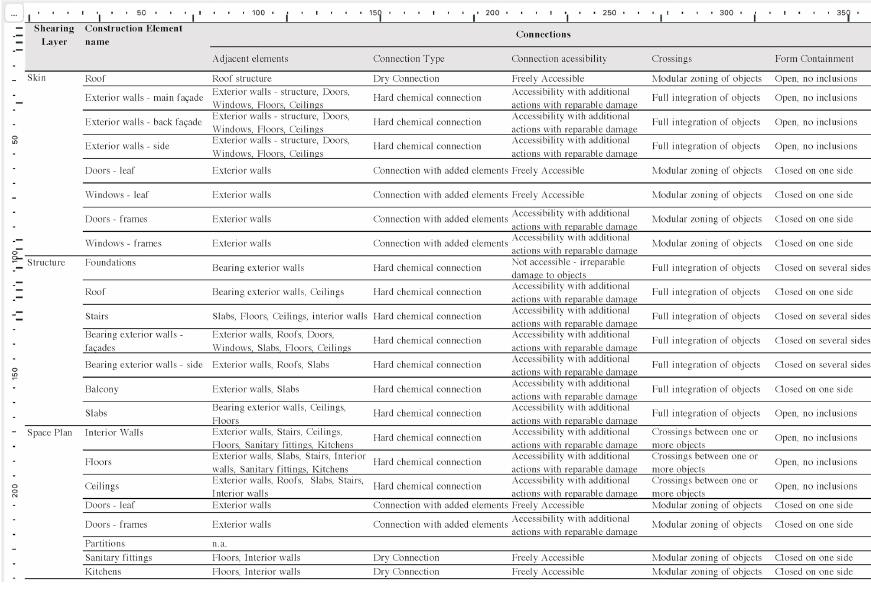
Figure 8. BAC – disassembly